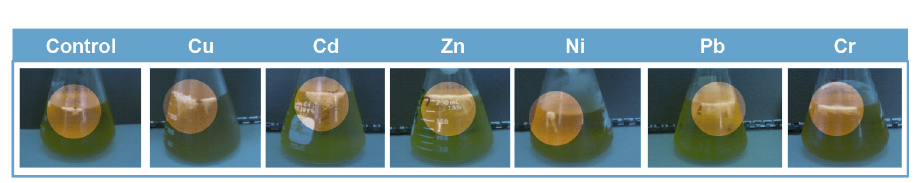
Fig 2. Qualitative Effect of Different Transition and Post-transition Metals in the Growth of Rhodotorula mucilaginosa strain UANL-001L and the Production of Exopolysaccharides. Production of exopolysaccharides is obtained when Rhodotorula mucilaginosa strain UANL-001L is grown in the presence of different transition and post-transition metals (Cd(II), Pb(II), Zn(II), Ni(II), Cu(II) and Cr(VI)) at concentrations of 0.05 g l -1 .